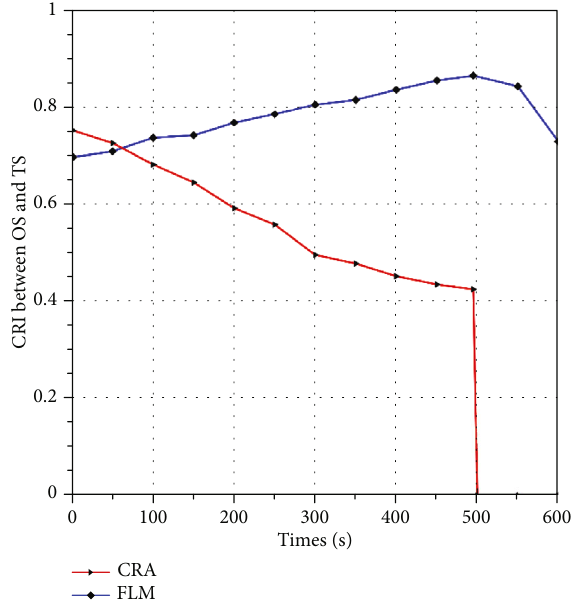
Figure 17: Comparison of CRA and FLM analysis